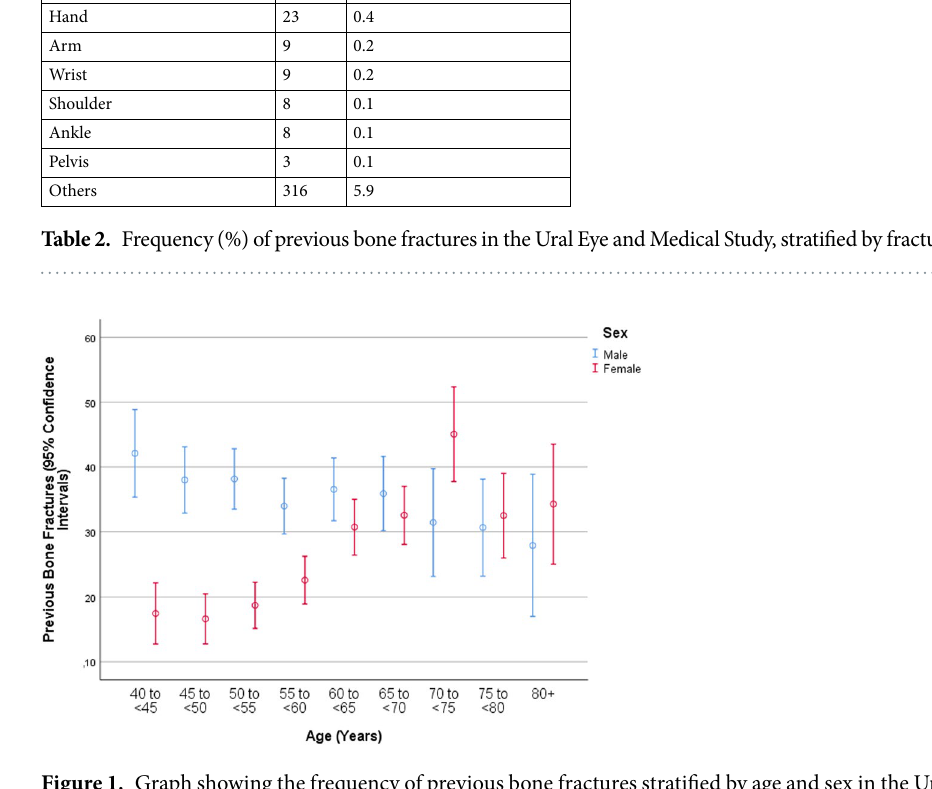
Figure 1. Graph showing the frequency of previous bone fractures stratified by age and sex in the Ural Eye and Medical